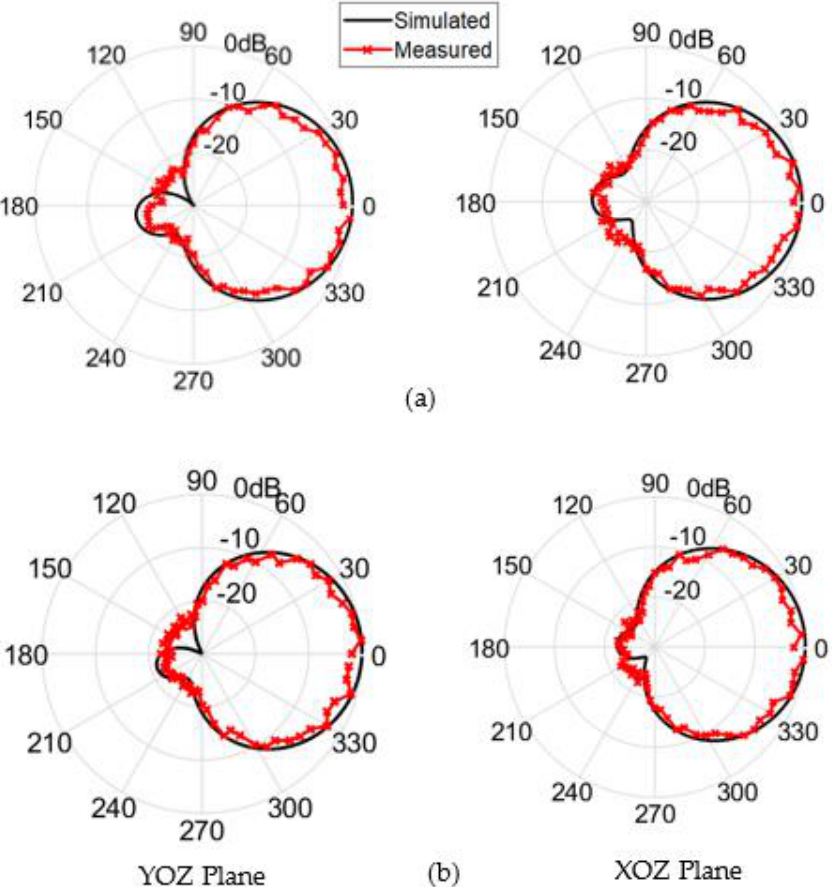
Figure 9. Simulation and measured normalized power patterns of the proposed single-element circularly polarized microstrip antenna at ( a ) 3.6 GHz and ( b ) 3.7 GHz.